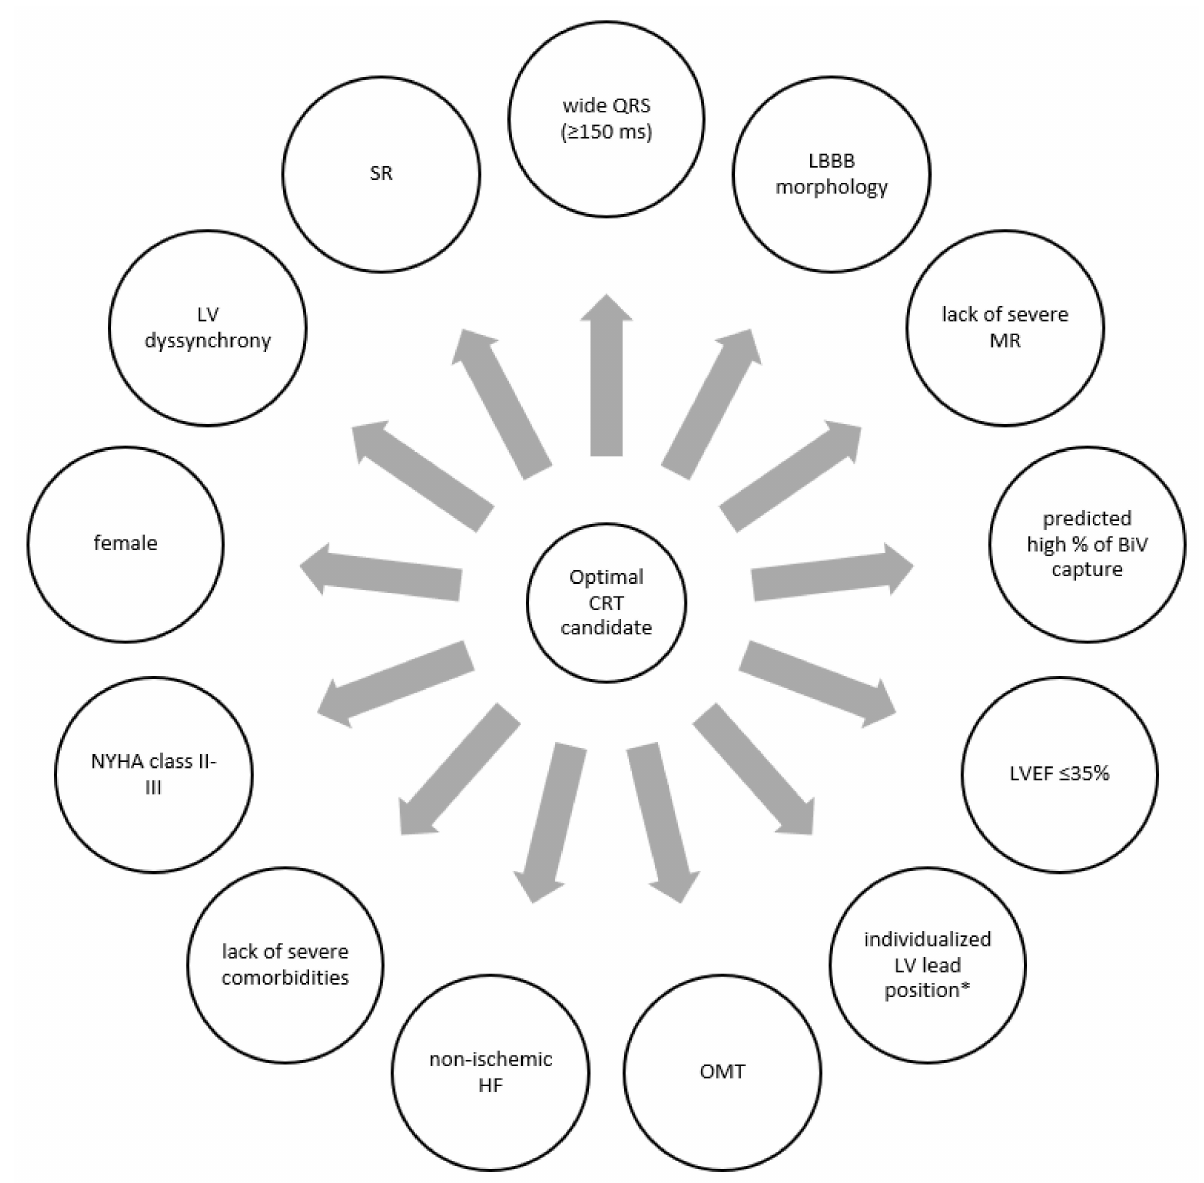
Figure 1. Selected clinical parameters associated with higher probability of favorable response to cardiac resynchronization therapy. BiV—biventricular; CRT—cardiac resynchronization therapy; HF—heart failure; LBBB—left bundle branch block; LV—left ventricle; LVEF—left ventricle ejection fraction; MR—mitral regurgitation; NYHA—New York Heart Association; OMT—optimal medical therapy; SR—sinus rhythm; %—percentage; * posterolateral lead position; correct pacing parameters; avoided scar